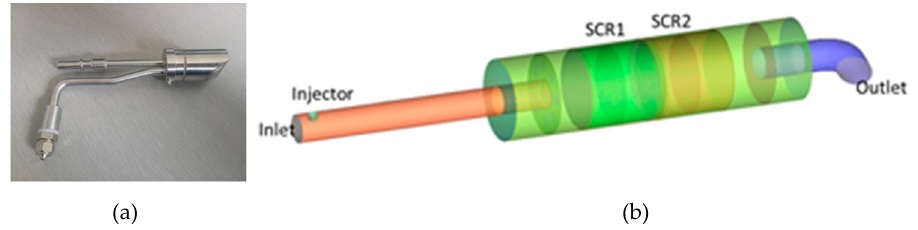
Figure 1. ( a ) Schematic diagram of the nozzle structure; and ( b ) Nozzle installation position in the SCR system.